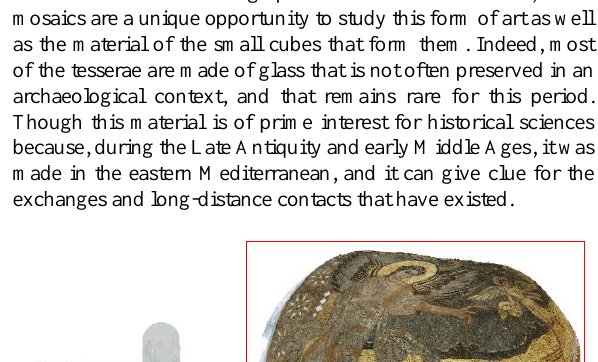
Figure 6. 1 cm x 1cm tessera with high density after the fusion of laser data with dense image matching.